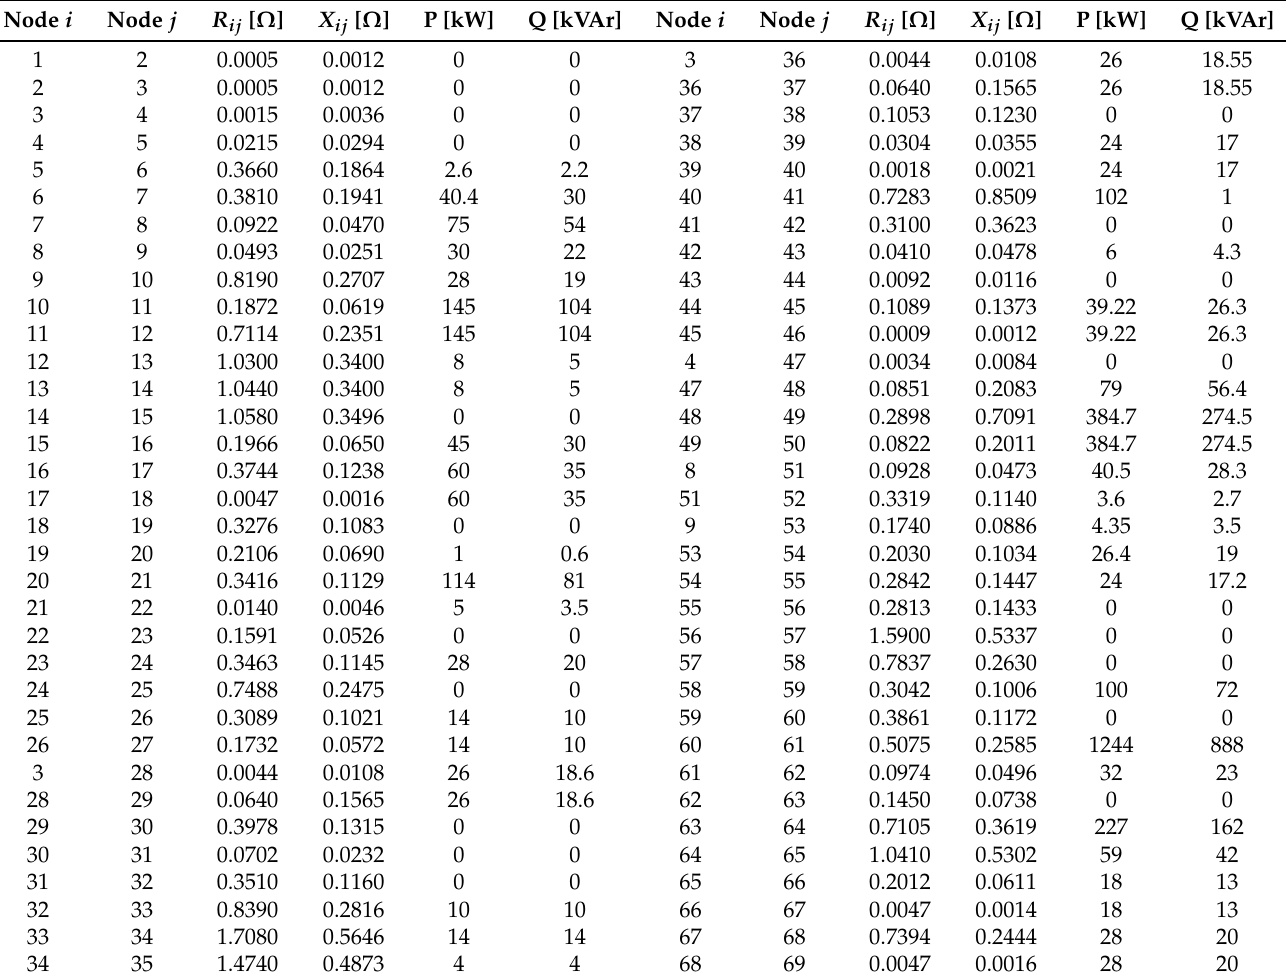
Table 5. Electrical parameters of the 69-node radial test